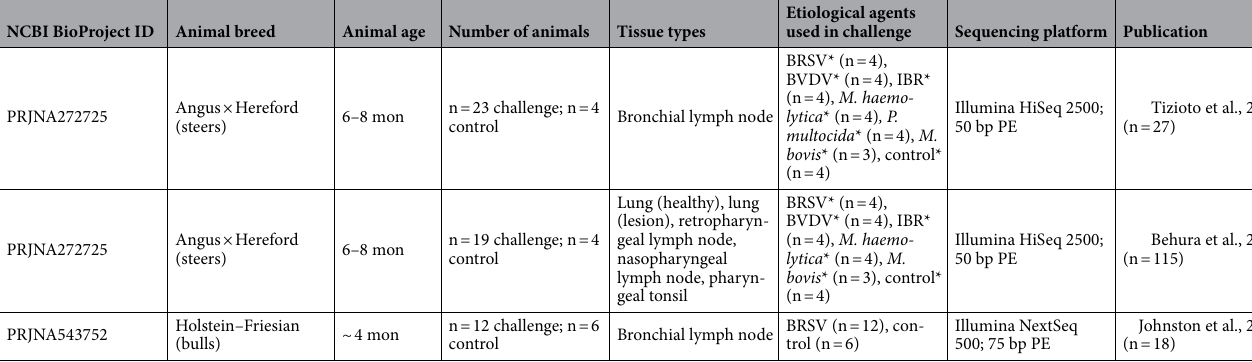
Table 1. Initial training datasets identified for ML testing. A total of 160 mRNA-Seq datasets were derived from lymph node and lung tissue of 31 cattle challenged with isolated BRD pathogens and 10 sham challenged controls. Asterisk (*) indicates different tissues collected from the same animals. Specifically, transcriptomes from tissues reported by Behura et al. 31 are from the same cattle from which Tizioto et al. analyzed bronchial lymph node transcriptomes (2015) except that P. multocida infected cattle reported by Tizioto et al. 30 are not included in the cohort reported by Behura et al. 31